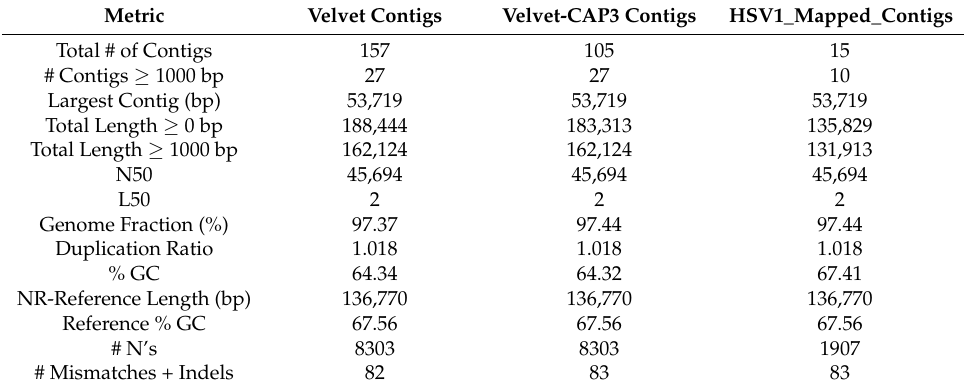
Table 2. 17syn+ De novo assembly metrics using the HSV1 reference (GenBank Accession Number: NC_001806). Assembly metrics generated by QUAST [27] are based on contigs greater than or equal to 500 bp in length, unless otherwise noted. Metric Velvet Contigs Velvet-CAP3